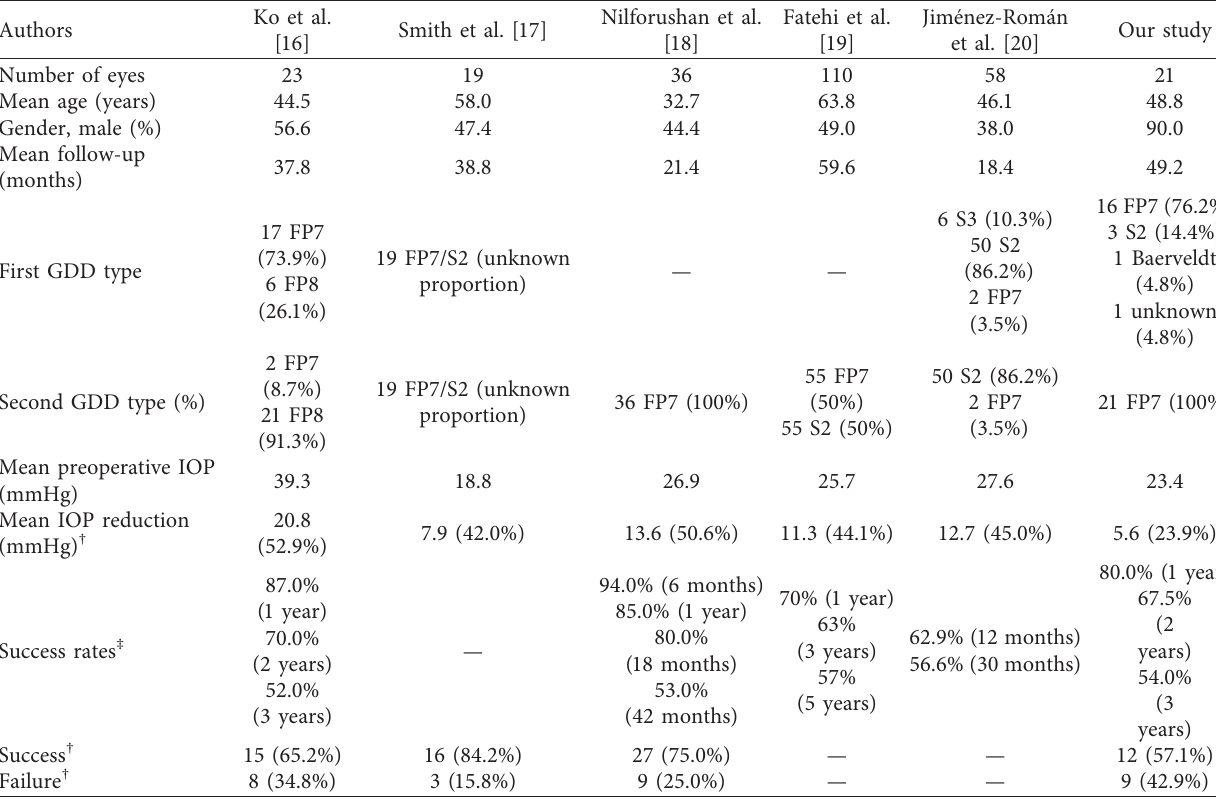
Table 3: Comparison of studies evaluating success rates and surgical outcomes of second Ahmed glaucoma valve